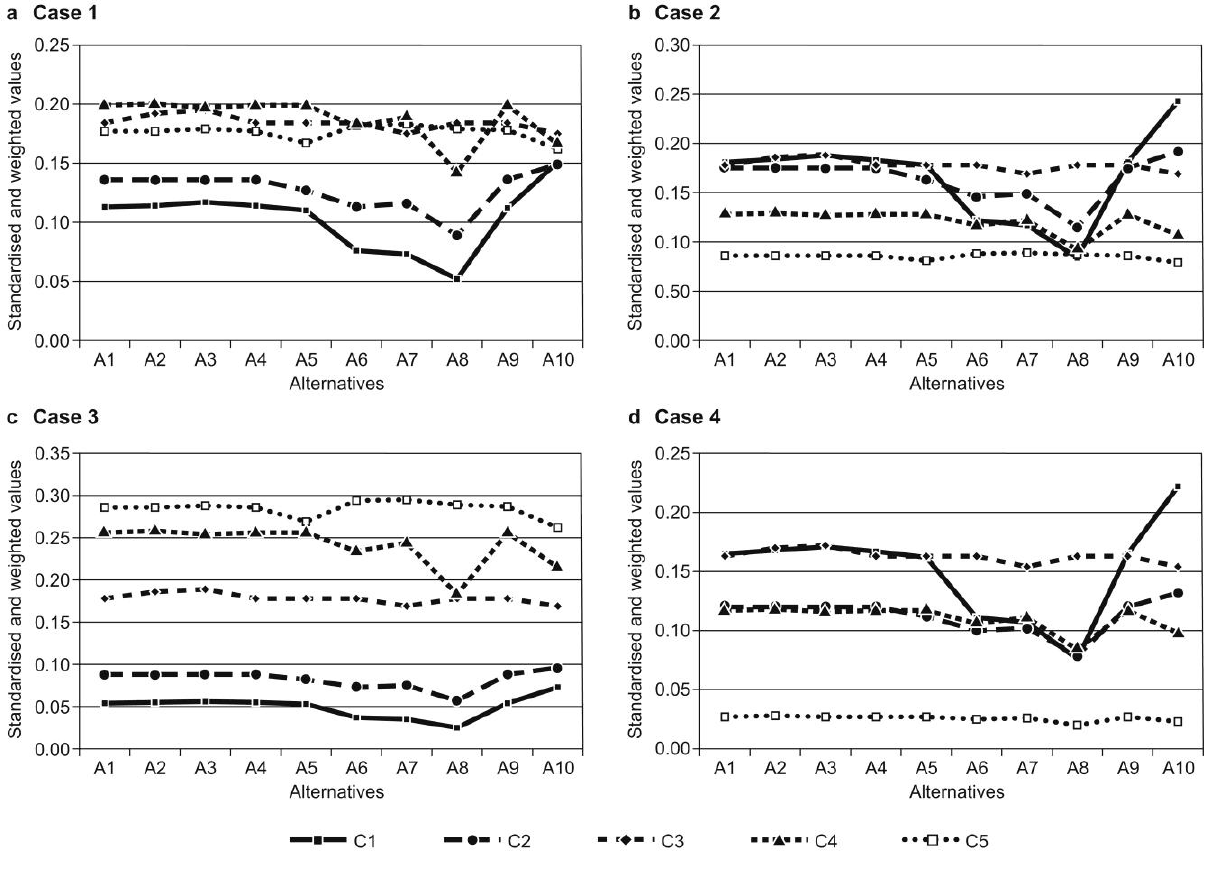
Figure 5. Performance of alternatives for all criteria in four cases.